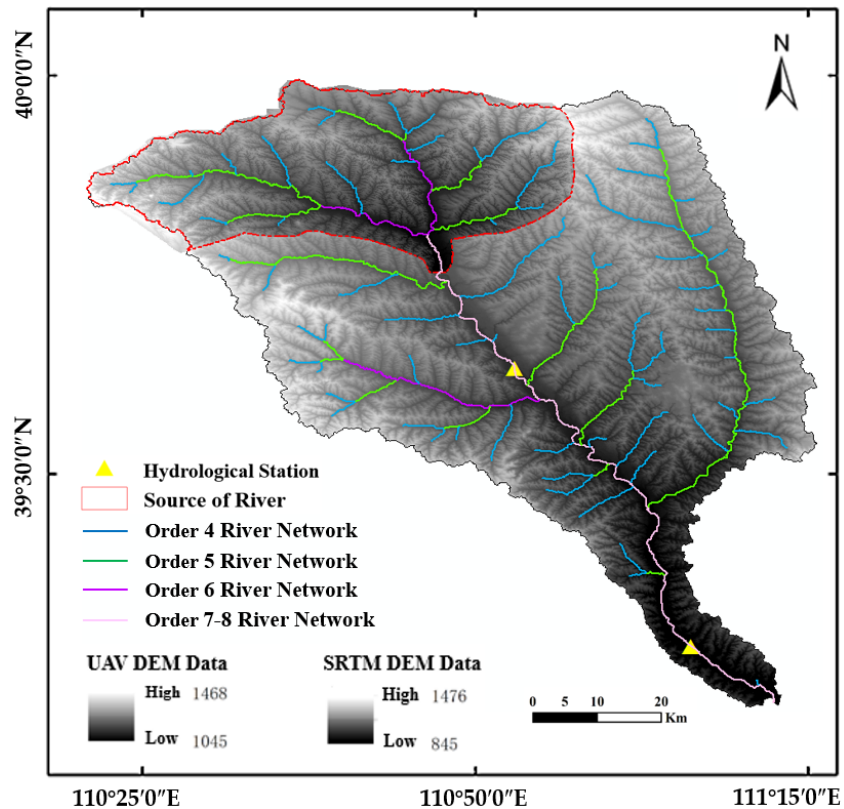
Figure 4. UAV DEM, SRTM DEM and river network in the Huangfuchuan River Basin.